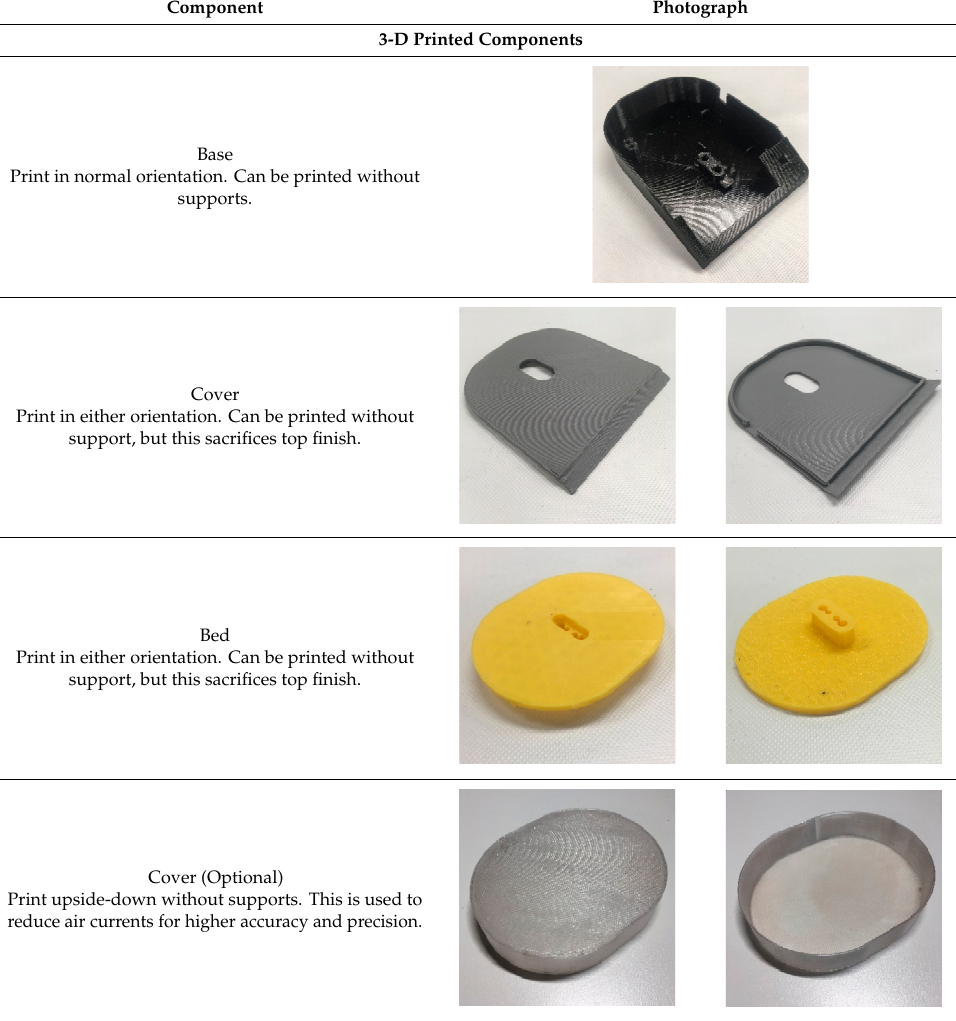
Table 1. Visual bill of materials separated by mechanical and electrical components. Component